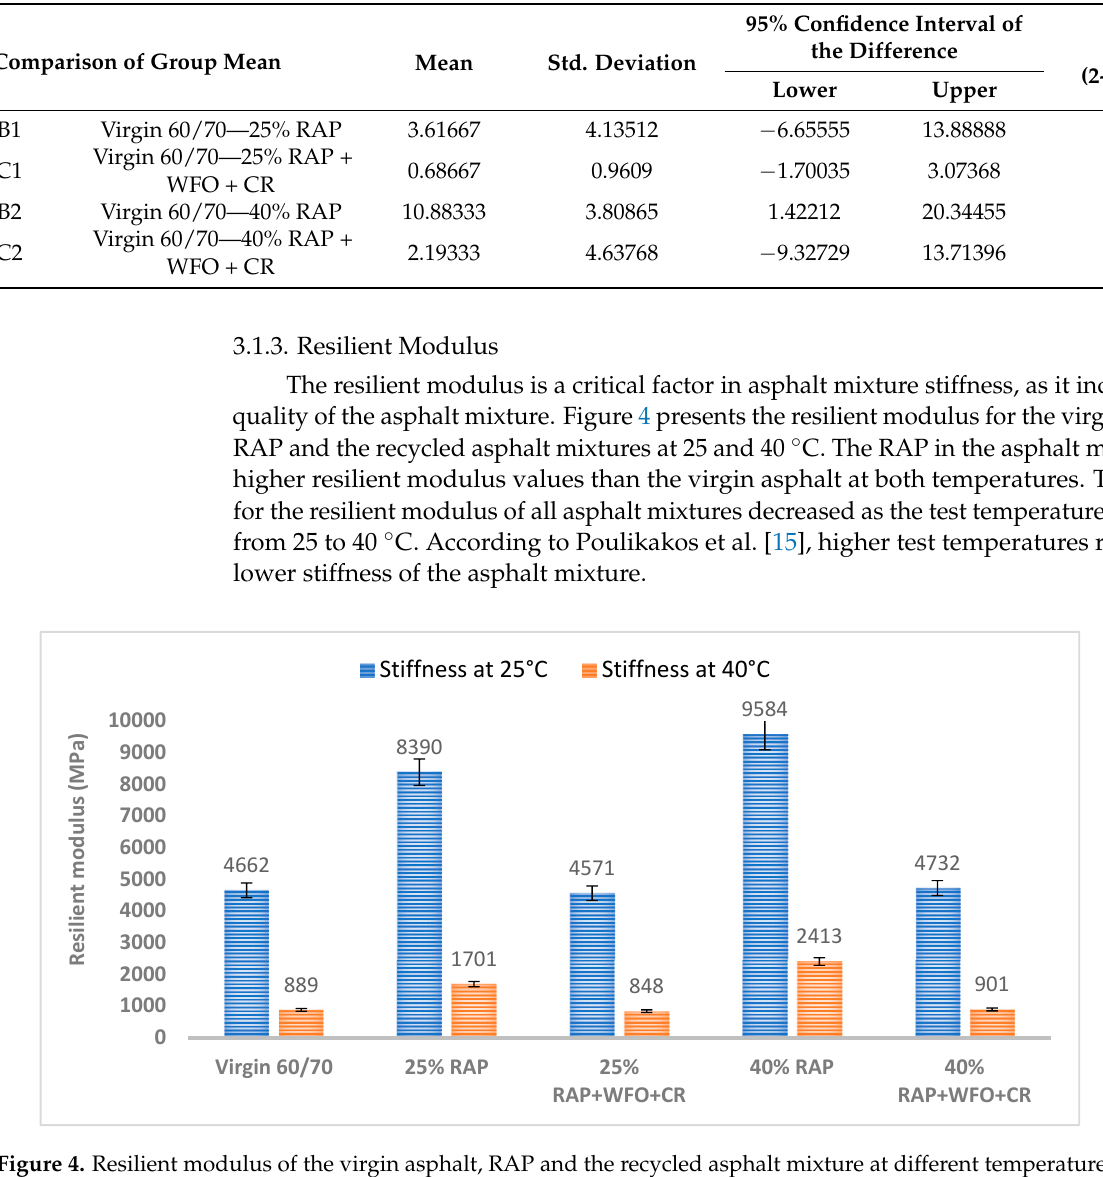
Table 15. The significant difference in the group means between the moisture sensitivity of the virgin asphalt with RAP and the recycled asphalt mixture.